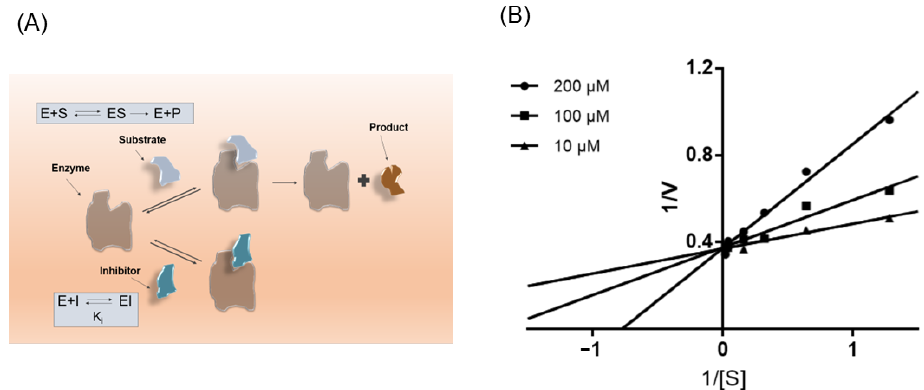
Figure 6. ISL is a noncompetitive inhibitor of NPC1L1. ( A ) Schematic diagram of the mode of action of competitive inhibitors. ( B ) Lineweaver-Burk plots in the presence of different concentrations of ISL.